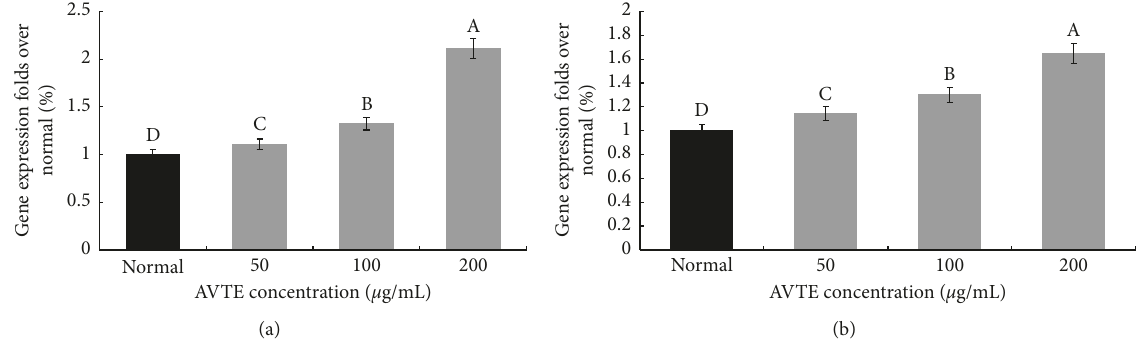
Figure 8: Effects of AVTE on the apoptotic gene expression of caspase-3 (a) and -9 (b) in human hepatoma HepG2 cells. Fold ratio of caspase-3 (a) and -9 (b) mRNA expression over the normal. The calculation formula is as follows: gene expression/GAPDH × normal numerical value (normal fold ratio: 1). A–D Mean values with different letters in the same bar graph are significantly different ( P < 0 . 05) according to Duncan’s multiple range